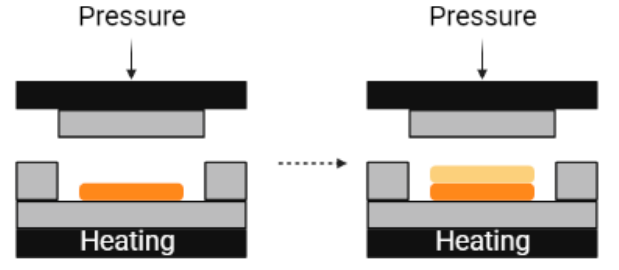
Figure 3. Schematic of process of bilayer film formation by the compression method.